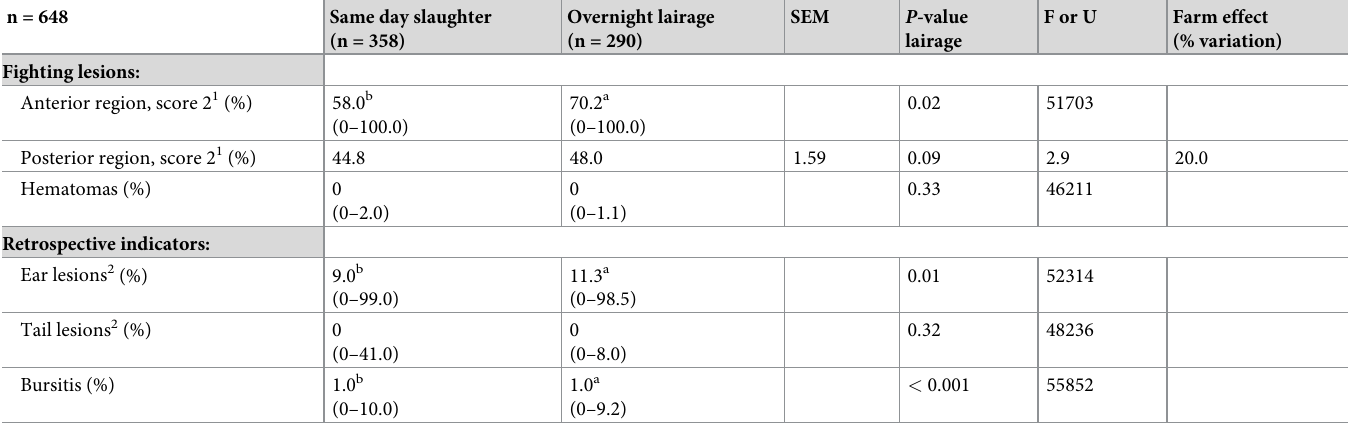
Table 2. Effect of lairage on the prevalence of different skin lesions detected in 648 batches of PDO Italian heavy pigs.